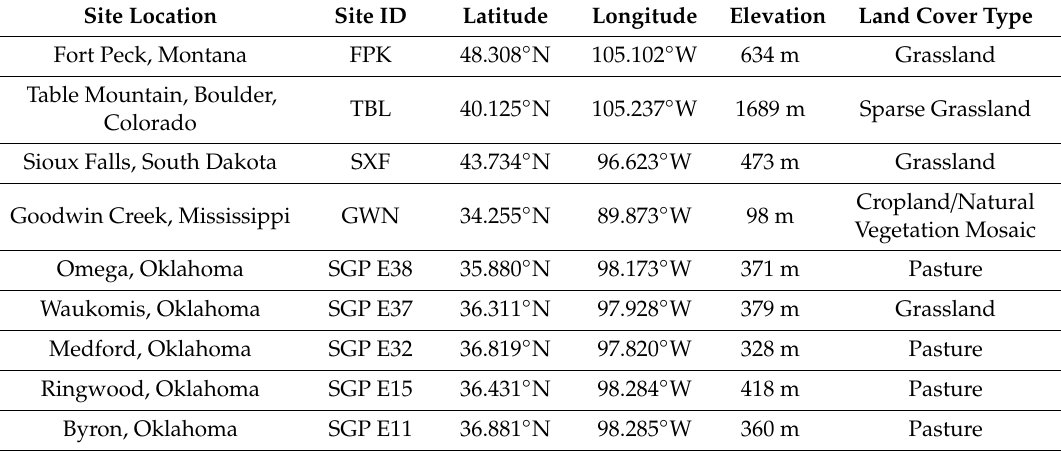
Table 1. Characteristics of the SURFRAD and ARM Southern Great Plains (SGP) validation sites used in the study.